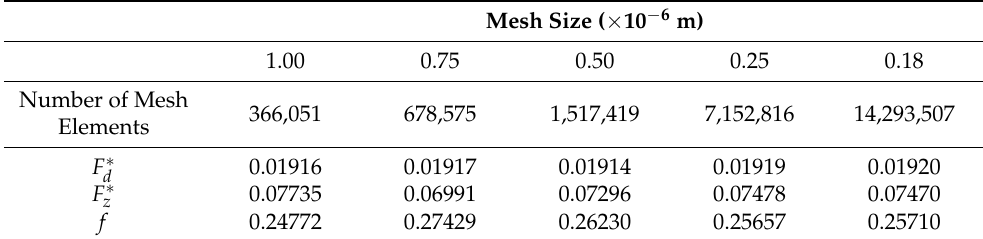
Table 2. Influence of mesh size on the load-carrying force F ∗ z , the shear force F ∗ coefficient f .